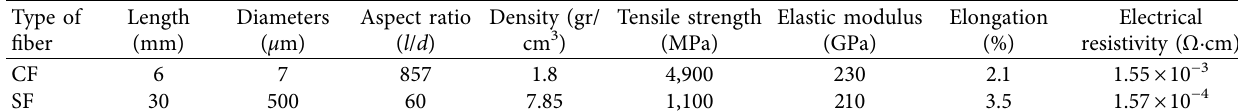
Table 2: Properties of conductive fbers used in this study.